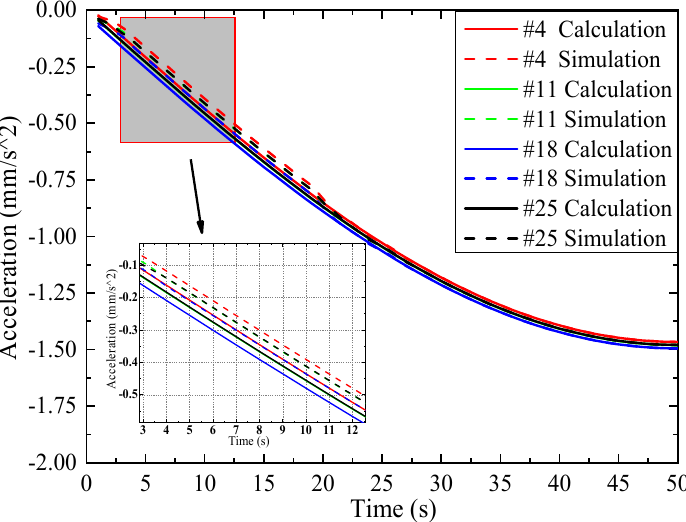
Figure 12. Acceleration–time diagram of different cylinders.